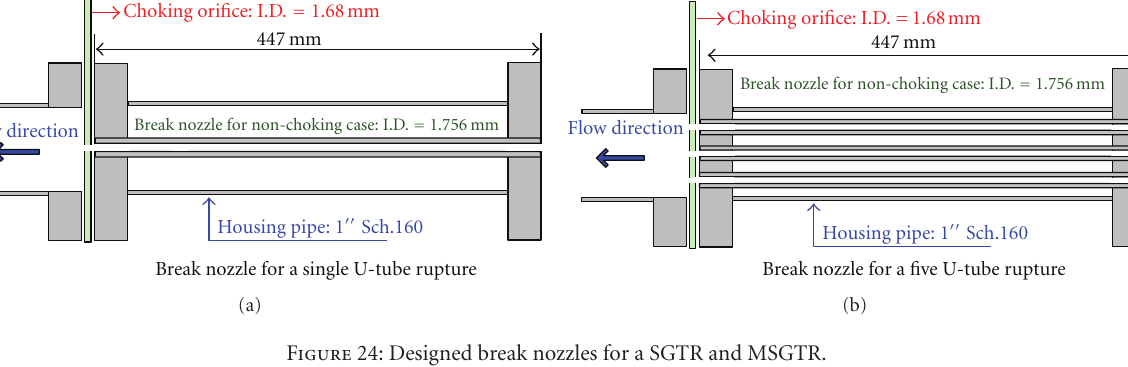
Figure 24: Designed break nozzles for a SGTR and MSGTR.